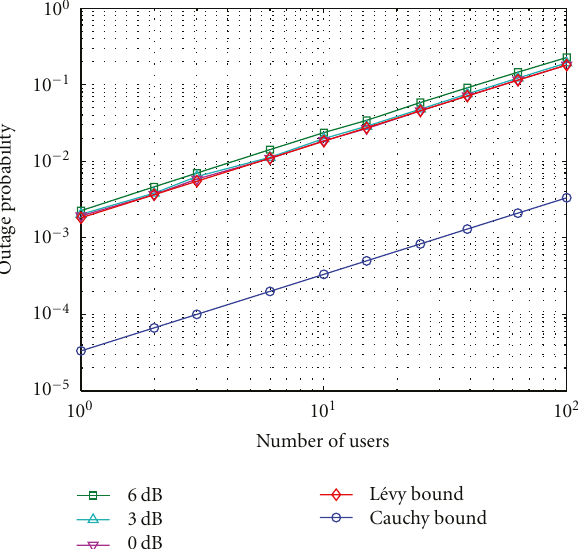
Figure 3: The outage probability P out versus the number of users N u in AWGN channels when α = 2, N s = 10, the shadowing standard derivations are, respectively, 0, 3, and 6dB.